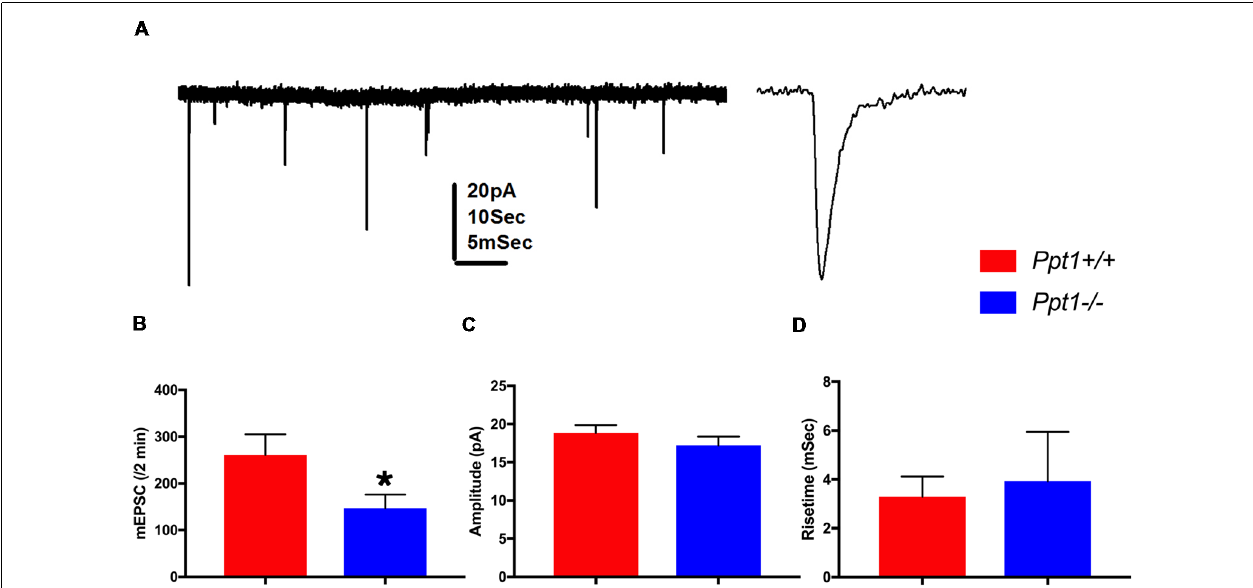
FIGURE 4 | Summary of recordings from wild-type controls and Ppt1 KO cells. (A) Illustration of spontaneous miniature EPSCs recorded from a cultured neuron voltage clamped at − 60 mV. Left, a continuous record at low speed, right a zoomed trace taken from the left record. Scale 20 pA for both, 10 s and 5 ms for the left and right traces, respectively. (B) Means of discharge rates of 16 controls and 18 Ppt1 − / − cells. (A) Significant reduction in discharge rate is seen ( t -test, ∗ p < 0.02). (C,D) No difference in amplitudes (C) or rise time (D) between the same two groups is